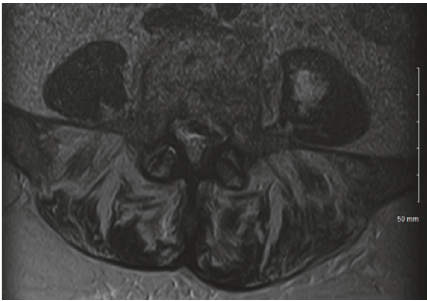
Figure 2: MRI of the lumbar spine on hospital day 3. This MRI shows a fluid collection within the left psoas muscle. The collection was aspirated and revealed purulent brown material, consistent with an abscess.